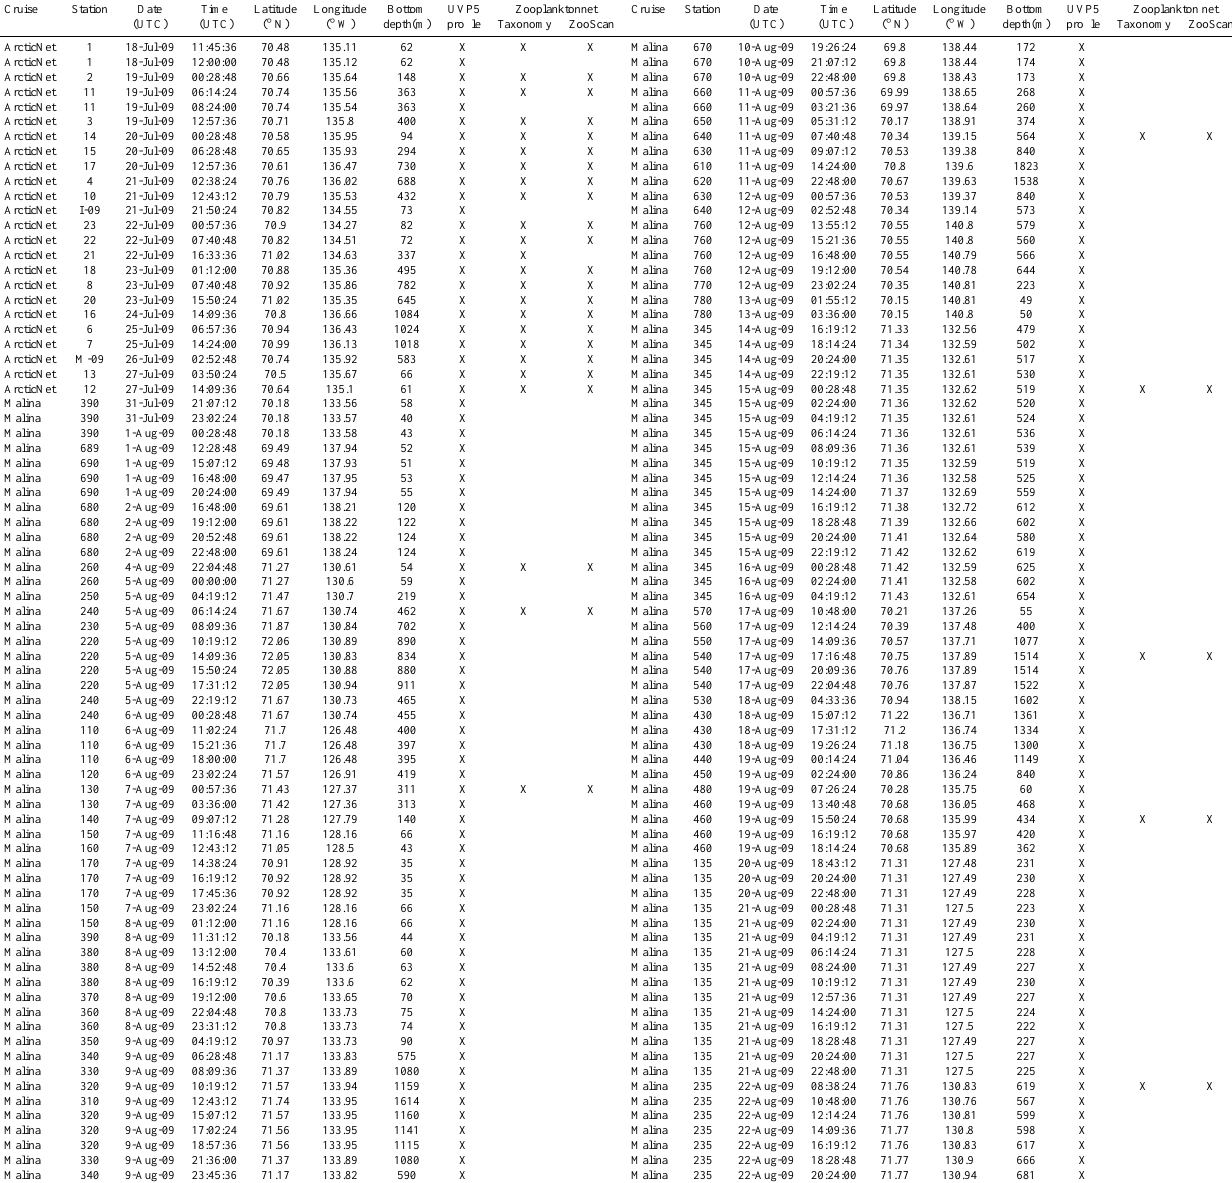
Table A1. List and metadata of oceanographic stations where sampling using an Underwater Vision Profiler 5 and traditional zooplankton nets was conducted in the southeast Beaufort Sea in July–August 2009 as part of the successive ArcticNet and Malina campaigns. Data from multiple UVP5 profiles conducted at each of the overlapping stations were averaged in order to perform comparisons with the vertical net tow